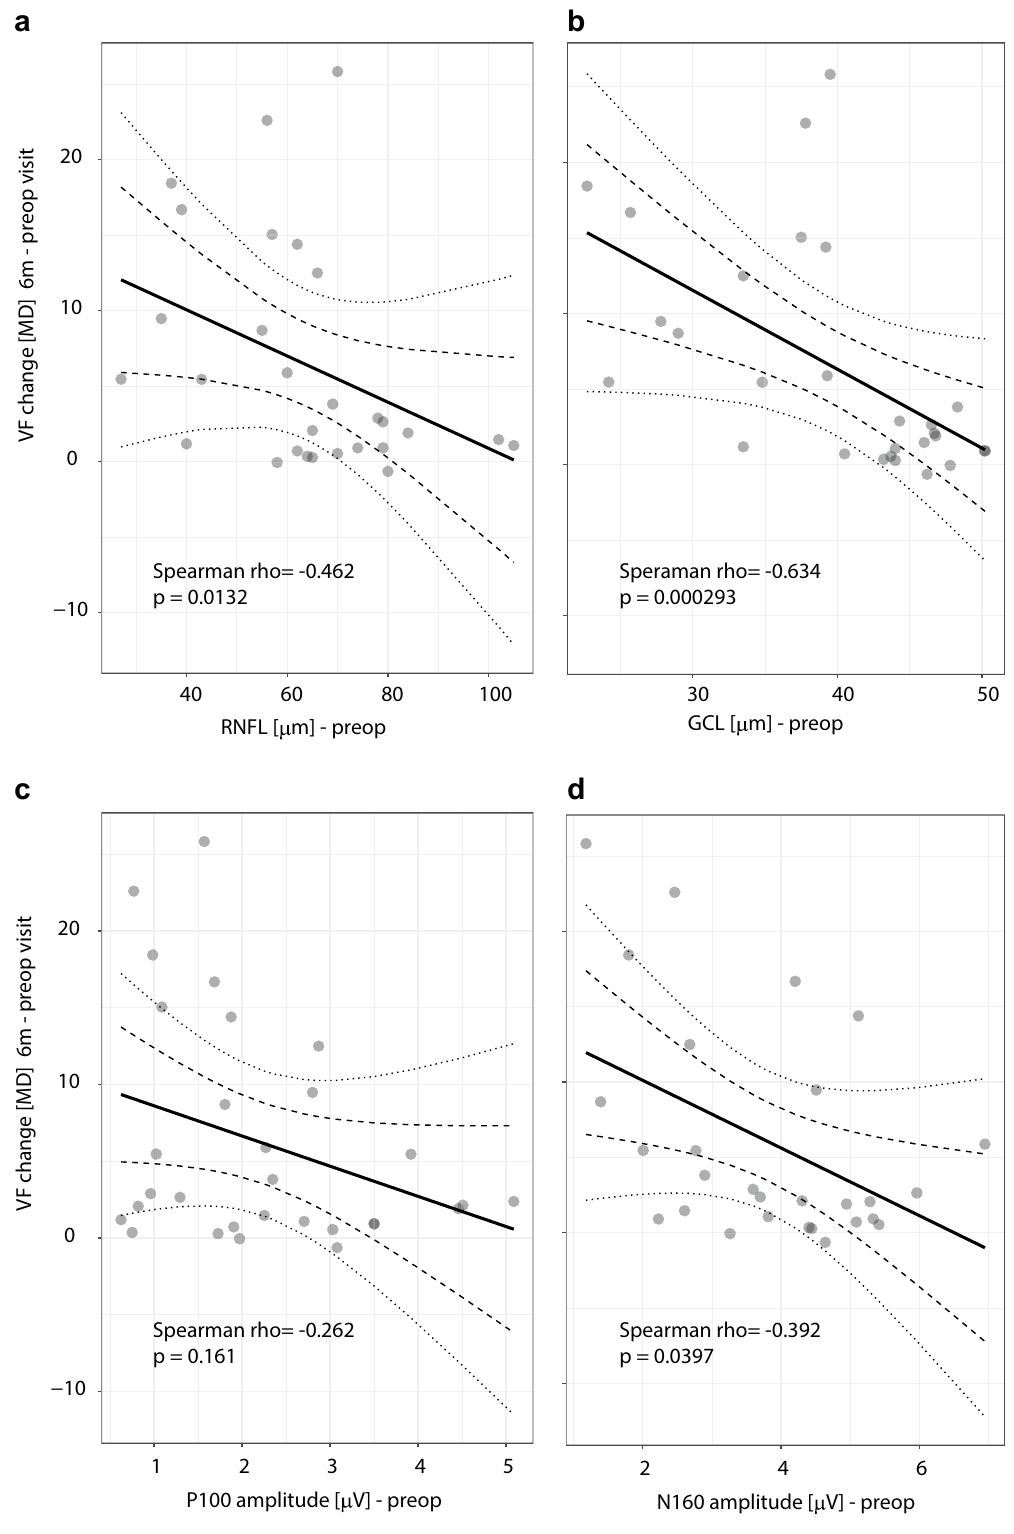
Figure 5. Plots illustrating the relationship between VF improvement and selected OCT ( a , b ) and VEPs ( c , d ) parameters. Higher is better for VF improvement, which was calculated as the difference between the last and the preoperative value of mean deviation (MD). The single dot represents one eye; the thick linear regression line is surrounded by dashed 99.9% and dotted 95.0% confidence intervals. A negative dependency between the VF improvement and preoperative state is evident in all plots. Such relationship illustrates a situation where the more affected initial state of the visual system is related to a higher benefit from the treatment. To note a statistically significant relationship between the improvement of and N160